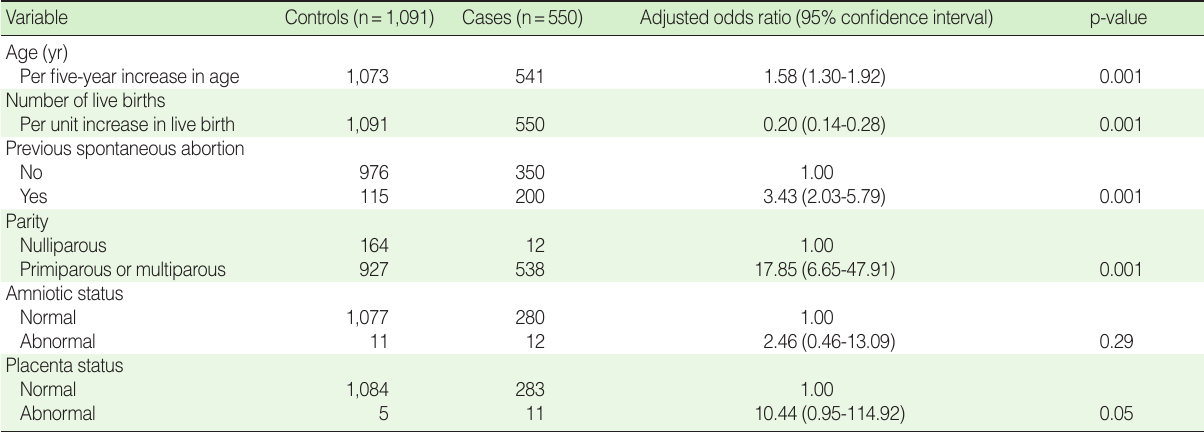
Table 3. Results from multivariate conditional logistic regression analyses of binary and continuous predictors of miscarriage, adjusted for all other variables in the model (pseudo R 2 =